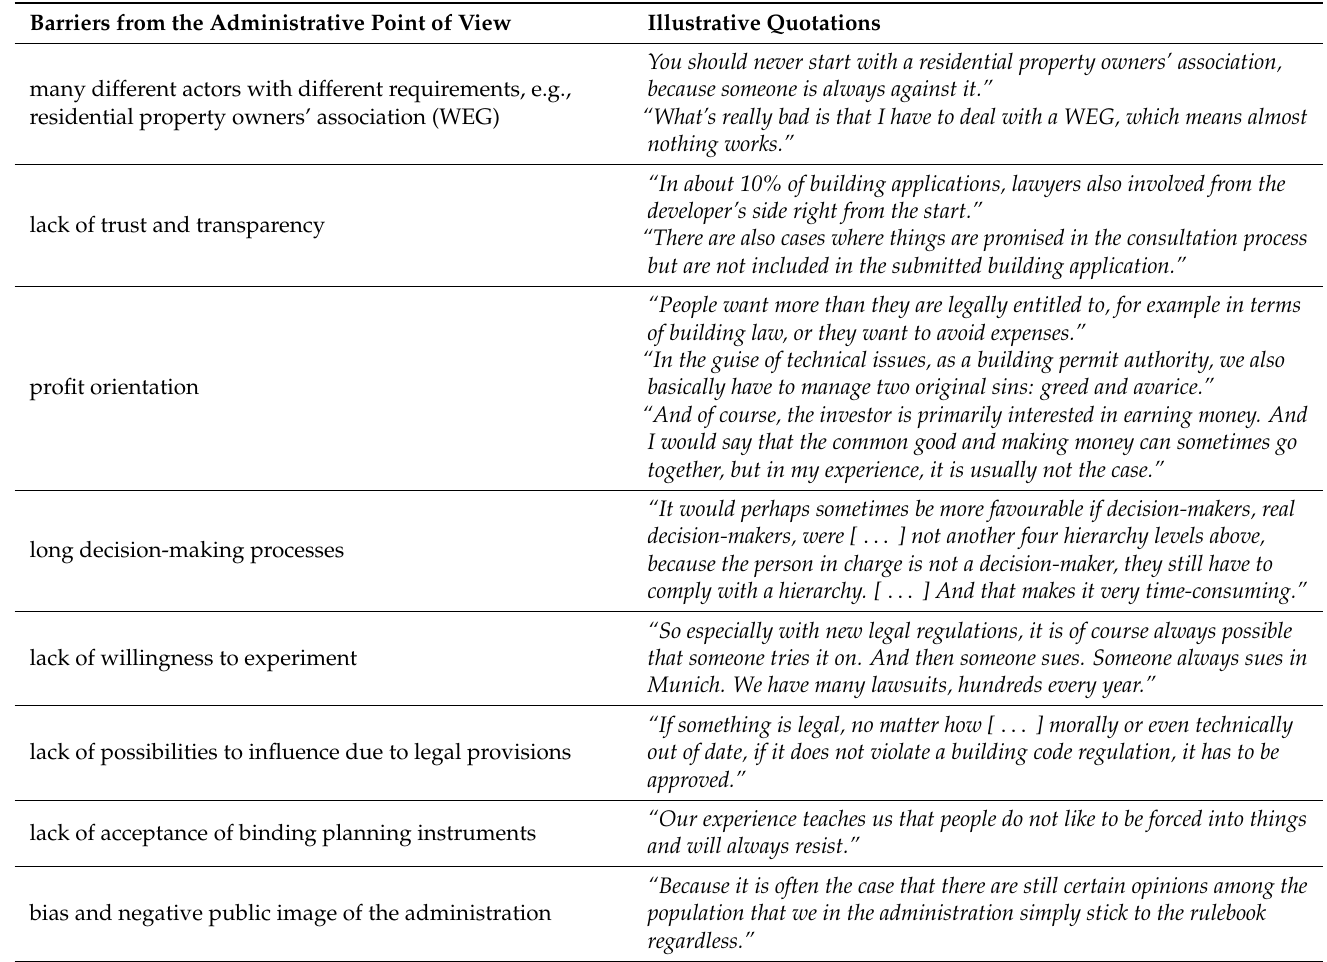
Table 6. Barriers linked to collaborative arrangements between administration and external